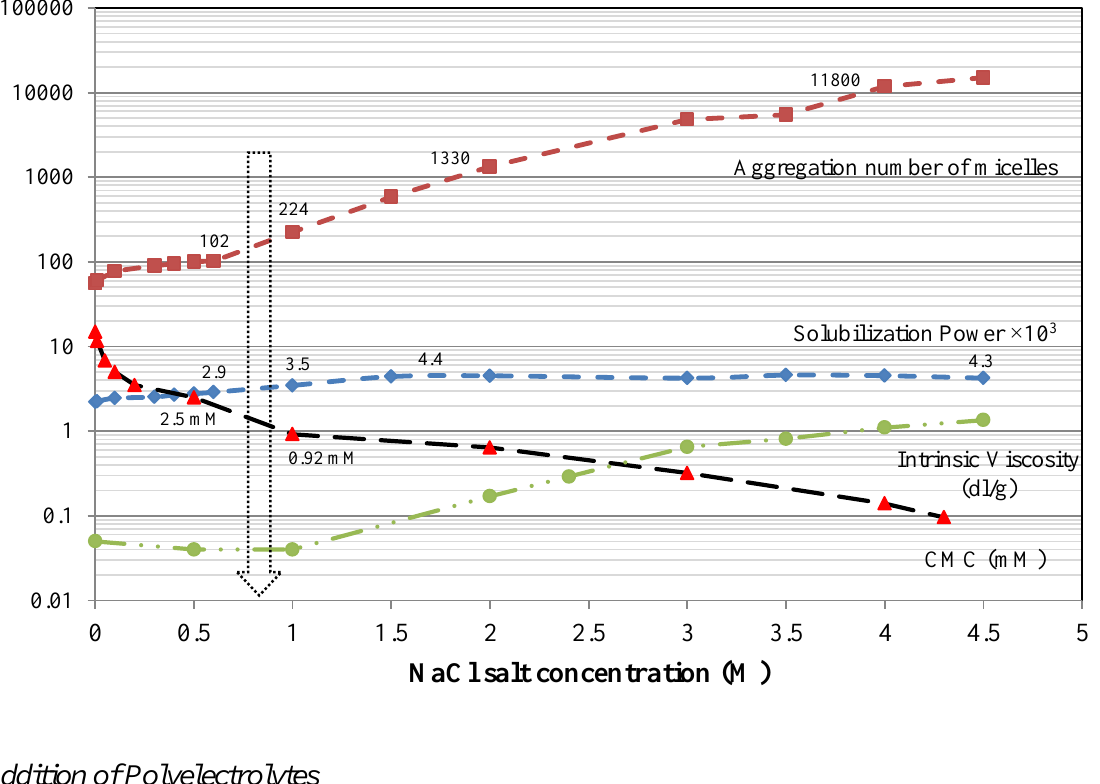
Figure 11. Aggregation number, solubilization power, intrinsic viscosity and critical micelle concentration (CMC) of dodecyltrimethylammonium chloride as a function of NaCl concentration. The dye used is C.I. Solvent Red 25 (Sudan IV) and the temperature was 25  C. Data from